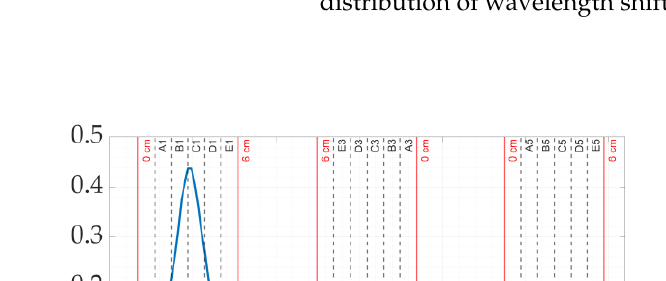
distance of 1 cm on the Y- axis respect to Figure 6. In Figure 9a–c are shown 2D maps of the distribution of wavelength shifts applying 50 g, 550 g, and 900 g, respectively.